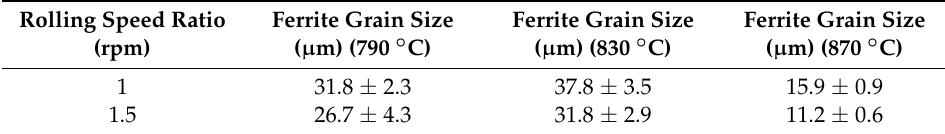
Table 2. Mean equivalent diameter (D 0 ) of the ferrite grains in terms of rolling temperature and rolling speed ratio.